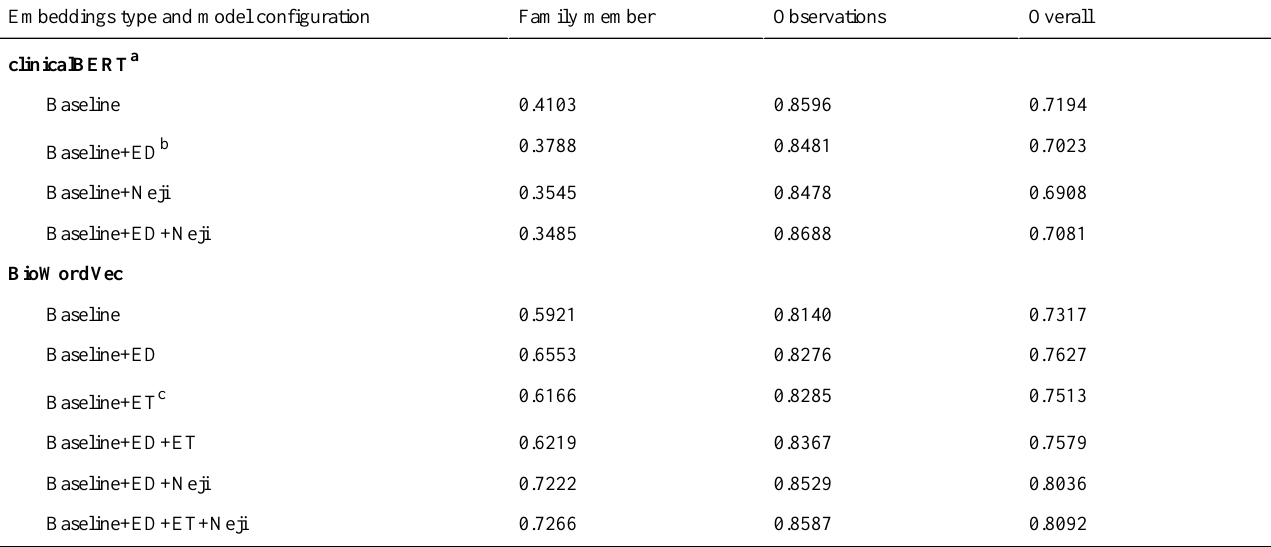
Table 5. Cross validation results on the training data set (5-fold cross validation) for subtask 1 using the attention-based bidirectional long short-term memory network coupled with conditional random fields with different types of embeddings. When using word embeddings, some configurations enabled embedding fine-tuning for 2 epochs. For simplicity purposes, only F1 scores are presented.